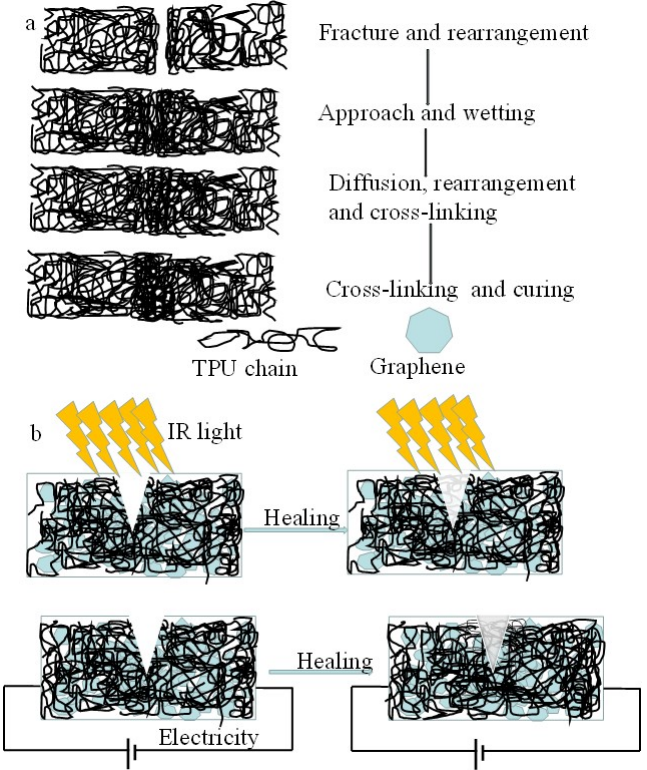
Figure 14. ( a ) crack healing theory and ( b ) schematic diagram of self-healing of the composite film by IR light and electricity, respectively.